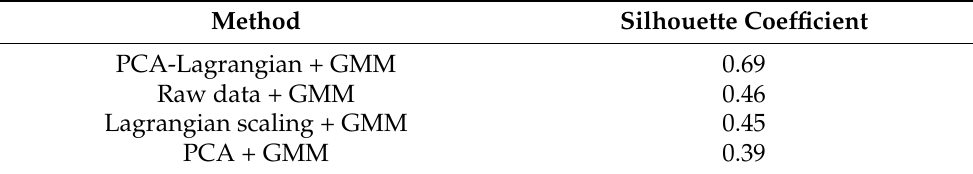
Table 2. Results of Silhouette coefficient for the Aarhus data set.